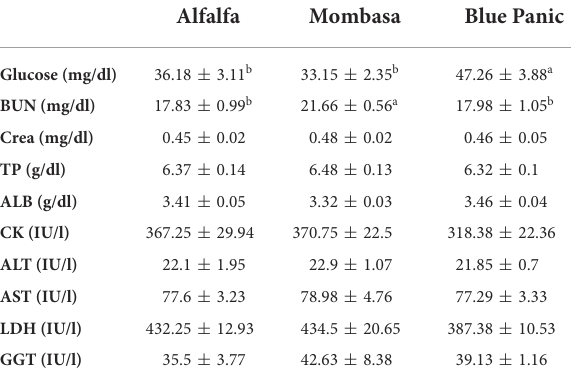
TABLE 6 Serum minerals in growing goats fed alfalfa, Mombasa, or blue panic.